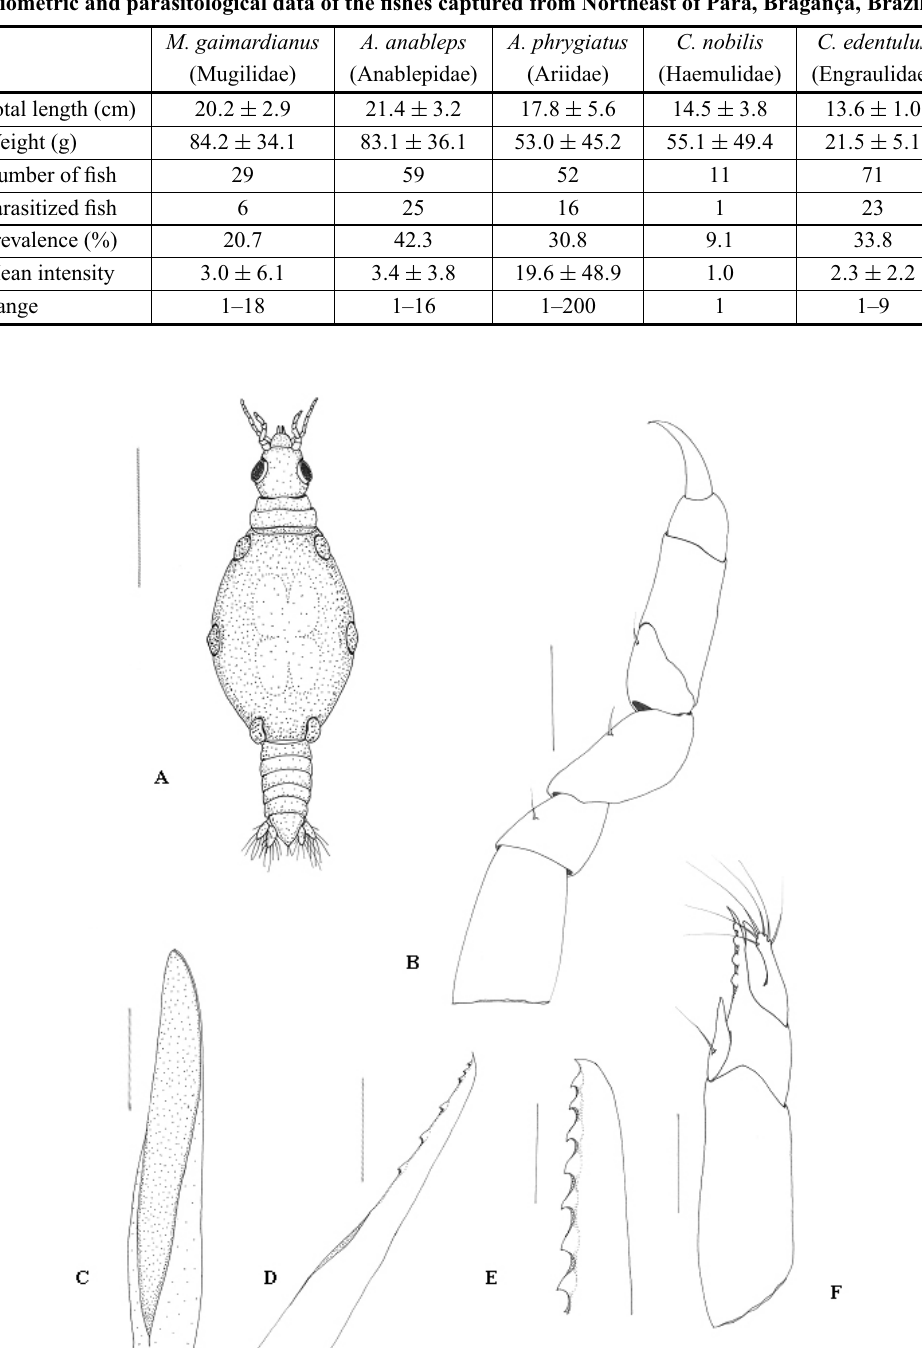
Fig. 1 – Praniza larvae collected from fishes of estuarine zone of Northeast of Pará, Brazil. A. Full length dorsal view. B: gnathopod. C: Paragnath. D: Maxillule. E: Mandible. F: Maxilliped. Scale bars: A = 600 μ m, B = 75 μ